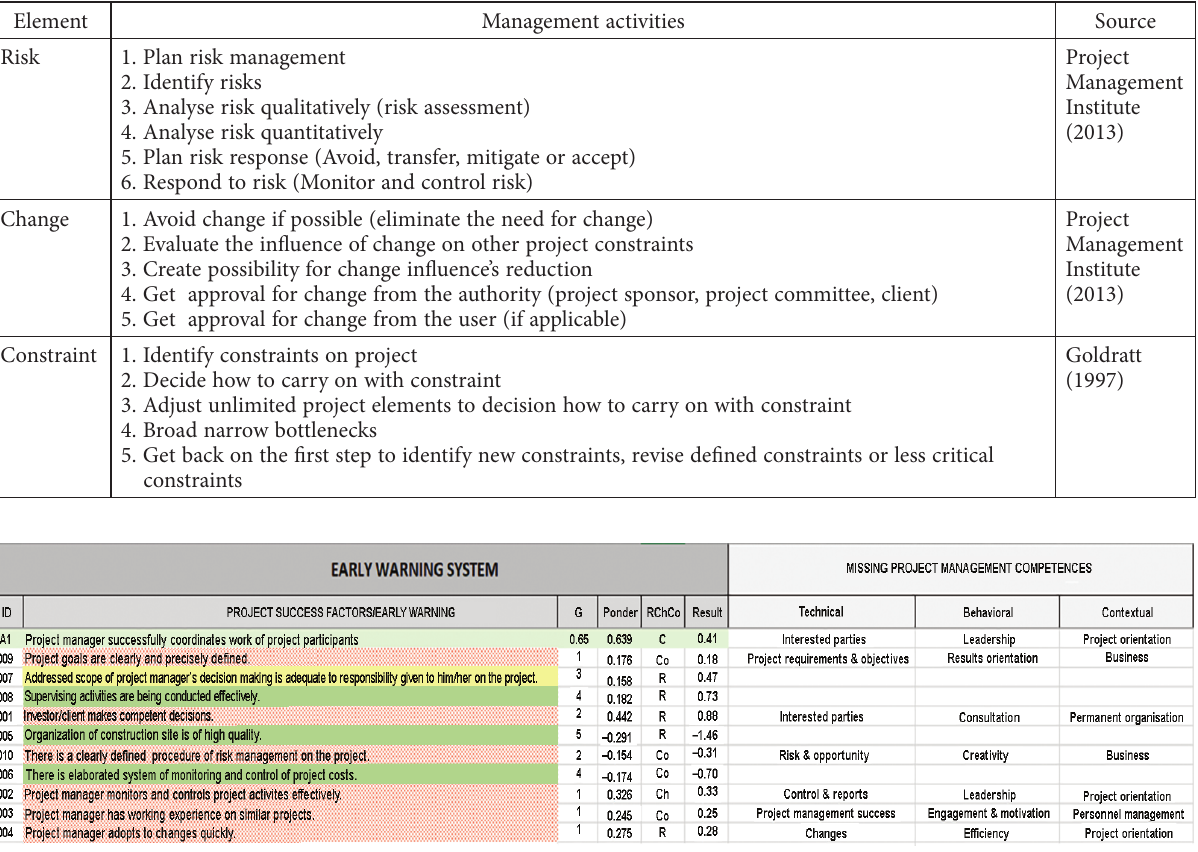
Table 4. Activities of managing risks, changes and constraints